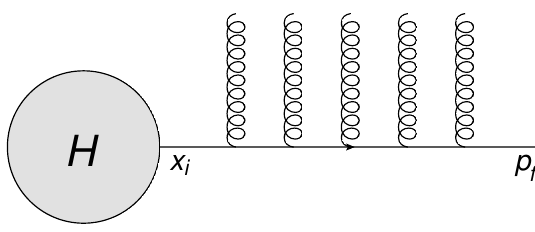
Figure 1 . Schematic depiction of a propagator dressed by soft radiation, from an initial state localized at position x i in the Hard function H to a final state of momentum p f